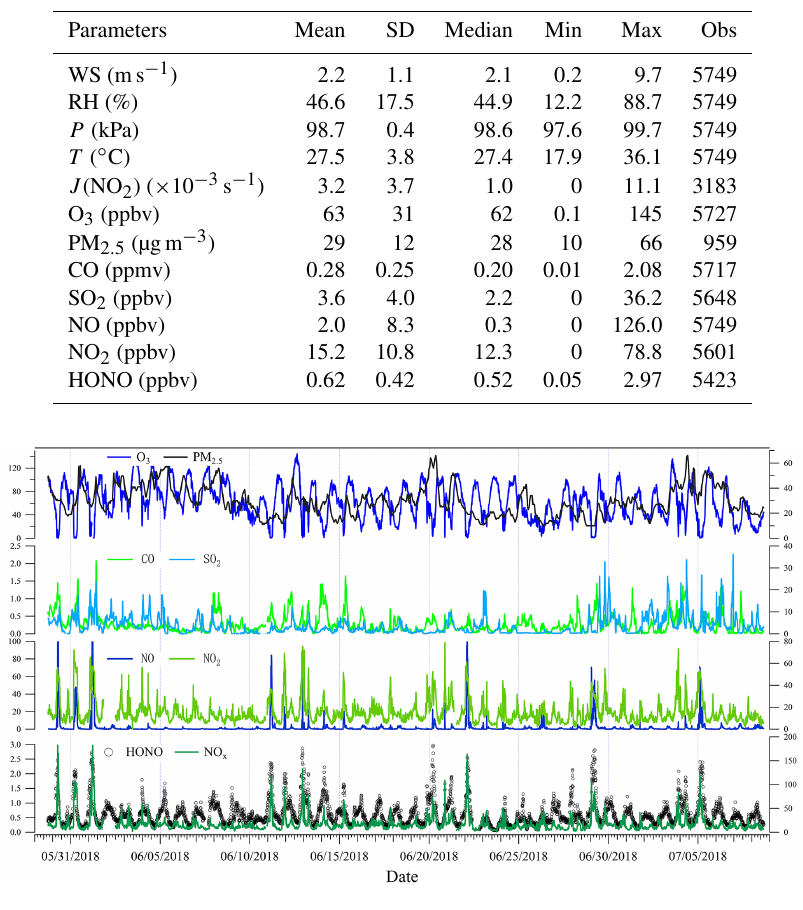
Figure 2. HONO and related species measured during the